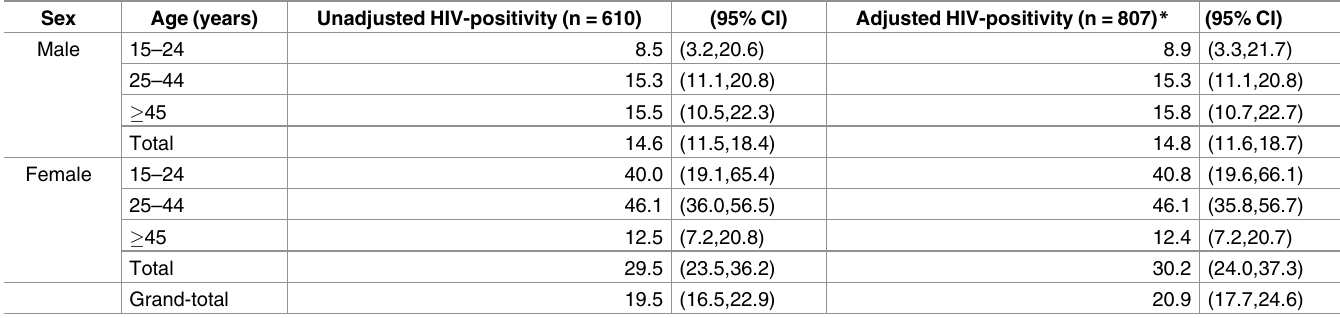
Table 1. Percent HIV positivity among cadaversat City and KNH mortuaries, Nairobi